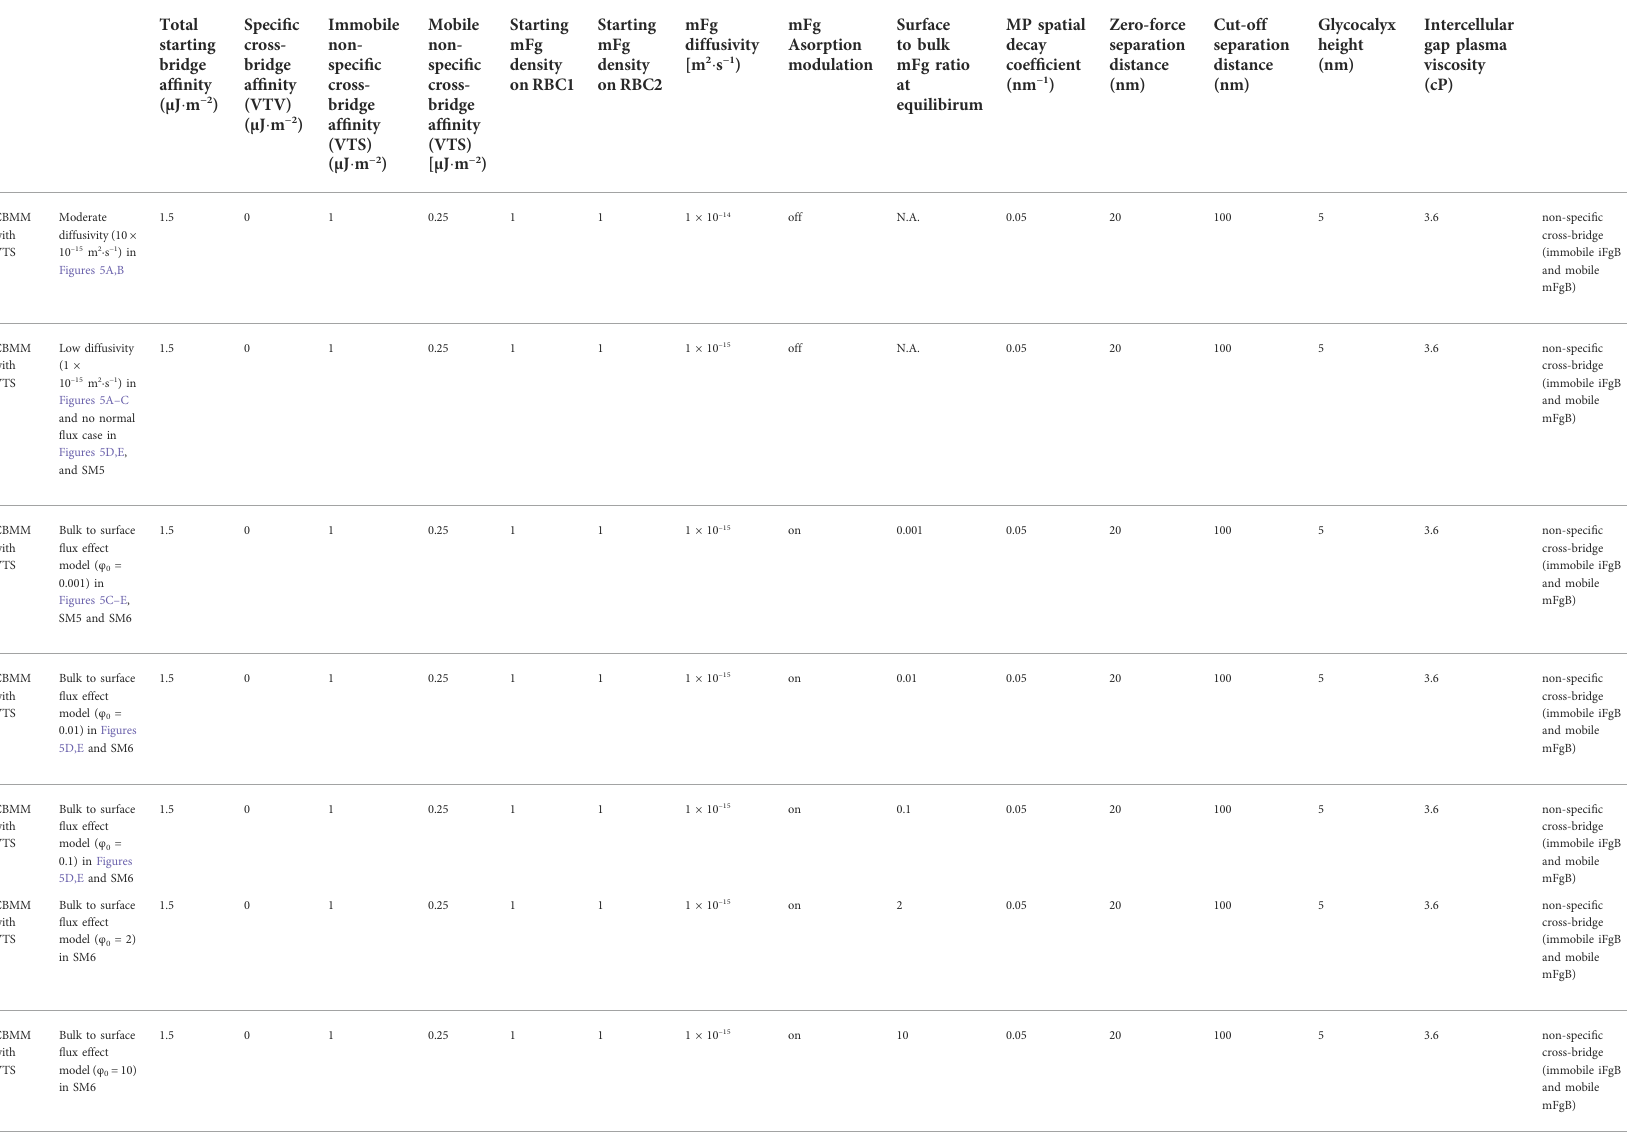
TABLE 3 ( Continued ) Simulation parameters for CBMM and UAM in doublet disaggregation